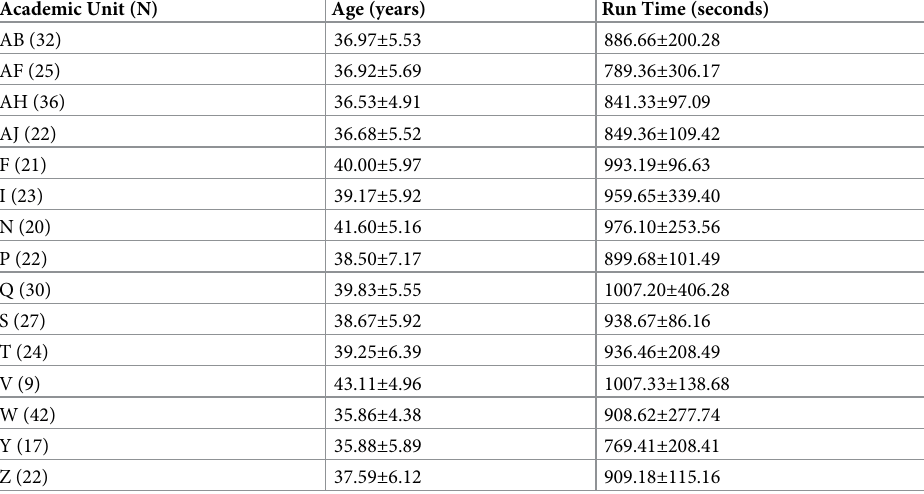
Table 1. Summary characteristics of participants by department/unit. Total numbers, age (years), and performance on the Army Physical Fitness Test (APFT) 2-mile run event (sec) are